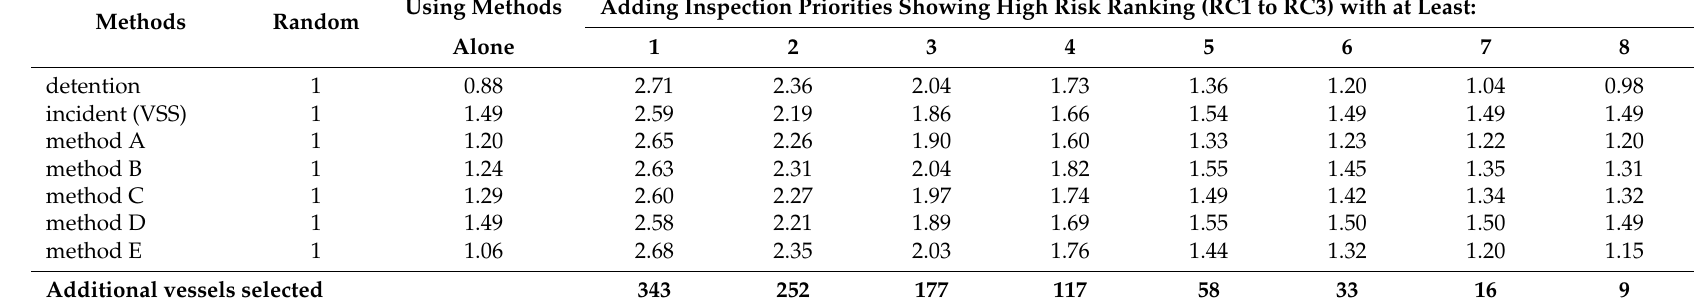
Table 7. Improvement in targeting by adding priority risk areas (relative true positive hit